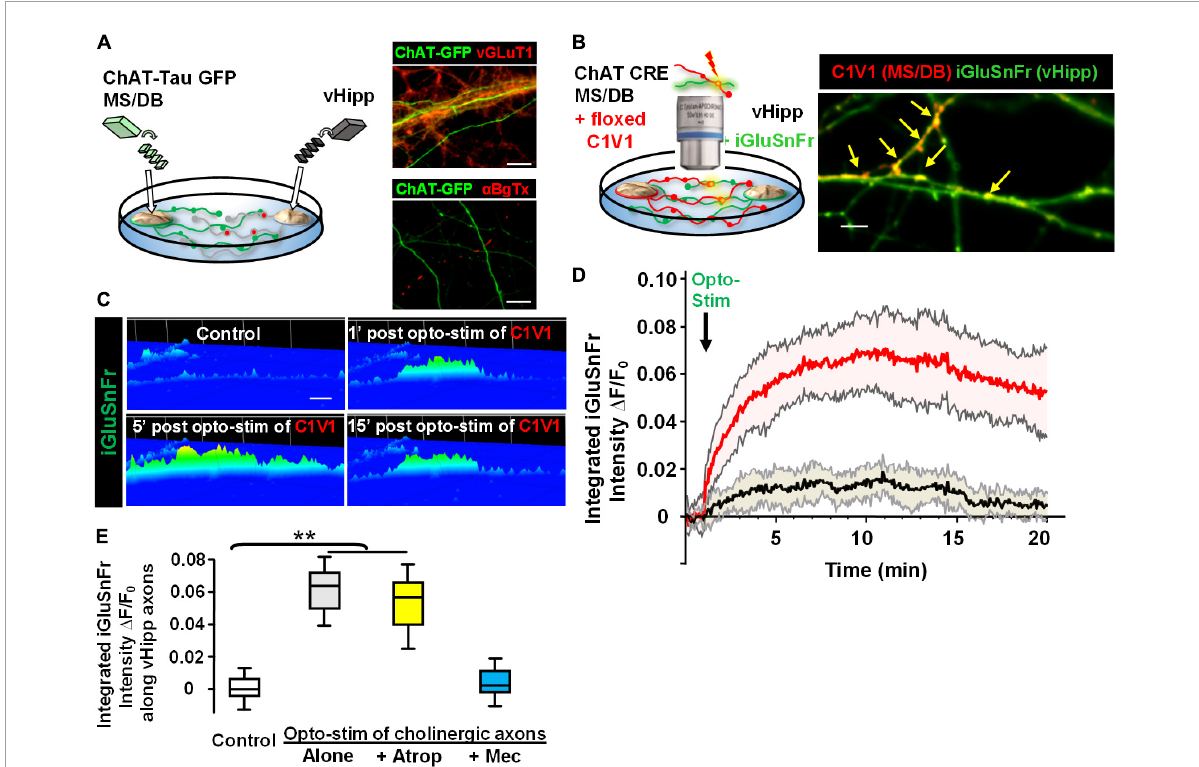
FIGURE7 Opto-stimulation of C1V1-expressing MS/DB cholinergic projections elicits glutamate release along co-cultured vHipp axons via nAChRs. Endogenous cholinergic modulation of glutamatergic signaling was examined in co-cultures of septal (MS/DB)-ventral hippocampal micro explants, focusing on sites of axo-axonic interactions. (A) Left: Schematic diagram of experimental configuration: vHipp, thinned micro-explants were prepared from WT mice and plated as delineated in Section “Materials and methods.” Twenty-four hours post plating, MS/DB cholinergic explants were prepared from ChAT-tau-GFP mice. After 7–10 days in vitro , these septal-hippocampal co-cultures were labeled for vGluT1 (anti-vesicular glutamate transporter 1) and/or surface α 7* nAChRs ( α BgTX-Alexa 594). (A) (Right, Top) Representative confocal images of GFP labeled cholinergic projections from MS/DB explants of ChAT-tau-GFP mice (in green), intermingled with vGluT1 + (red) projections from vHipp. Scale bar: 10 µ m. (Right, Bottom) Different representative images of GFP labeled cholinergic projections from MS/DB explants of ChAT-tau-GFP mice (in green), intermingled with α BgTX + labeled (red) projections from vHipp. Note that α BgTX + ( α 7* nAChRs) labeling was only detected along GFP negative, vHipp axons, but not along GFP positive MS/DB axons. Scale bar: 10 µ m. (B) Left: Schematic diagram of experimental configuration used to assess endogenous ACh-evoked glutamate release at axo-axonic contacts between MS/DB and vHipp. Micro-explants of vHipp were prepared from WT mice and plated as described in Section “Materials and methods.” To detect glutamate release from glutamatergic axons, iGluSnFr (AAV9.hSyn. iGluSnFr.WPRE .SV40) was added to the culture media to infect vHipp neurons for 24 h. Following washout of iGluSnFr, the explants of MS/DB from ChAT-IRES-Cre mice were plated on the same coverslip (Zhong et al., 2015). Cholinergic neurons were then selectively labeled with the floxed red-shifted variant of channel rhodopsin C1V1 (pAAV-Ef1a-DIO C1V1 (t/t)-TS-mCherry) by subsequent infection in vitro . After 7–10 days in vitro , the co-cultures of iGluSnFr labeled, glutamatergic-vHipp axons with C1V1-labeled cholinergic axons were subjected to concurrent optogenetic stimulation and recording of glutamate release. (B) Right: Representative confocal image of chimeric co-culture of C1V1 (in red) expressing ChAT-Cre MS/DB projections with multiple sites of contact (indicated by yellow arrows) with iGluSnFr expressing WT vHipp axons (green). Scale bar, 10 µ m. (C) Optogenetic stimulation of endogenous ACh release from MS/DB axons induced glutamate release from contacted vHipp axons. Representative spinning disk confocal iGluSnFr images recorded from WT vHipp axons before and after photo-stimulation (100 flashes of 594 nm light, 10 Hz × 10 s; 5 ms duration) of C1V1 expressed MS/DB axons (spatio-temporal distribution of iGluSnFr signal is represented in pseudo color. Scale bar: 5 µ m). (D) Averaged traces of the time course of changes in glutamate release (normalized iGluSnFr intensity) along vHipp axons following optogenetic stimulation of endogenous ACh release from MS/DB axons. Averaged changes in iGluSnFr intensity as a function of time in 21 vHipp axons from 3 separate experiments before and after photo-stimulation ( n = 21,3: red; SD shown in shaded pink). The vHipp axons were contacted by co-cultured MS/DB axons expressing C1V1 (as the yellow arrow shown in B ). The black line shows the averaged changes in iGluSnFr intensity time course from 9 vHipp axons without cholinergic input before and after photo-stimulation ( n = 9, 3 black line; SD gray shading). Although these vhipp axons were also co-cultured with C1V1 expressing MS/DB micro-explants, no points of C1V1 contact were evident. Note that the robust, opto-stimulated, glutamate release seen at cholinergic axon-vHipp axonic contacts was not detected along vHipp axons that were not contacted by C1V1 expressing cholinergic axons. (E) Box plots of pooled data showed photo-stimulation of C1V1 expressing MS/DB axons under control conditions (** p < 0.01, n = 30, 6 co-cultures) or with concurrent incubation with atropine (0.5 µ M, n = 10,3 ** p < 0.01) evoked a significant and sustained increase in the integrated iGluSnFr fluorescence intensity along contacted vHipp axons. In contrast, photo-stimulation in the presence of mecamylamine (10 µ M, n = 10, 3, p > 0.05), was without effect, consistent with nicotinic ACh receptor mediated, ACh-evoked glutamate release. All data were first tested for distribution normality by the test(s) listed in Table 1 prior to statistical analysis. See Table 1 and Figure (E) panel-specific data for all n values and statistical